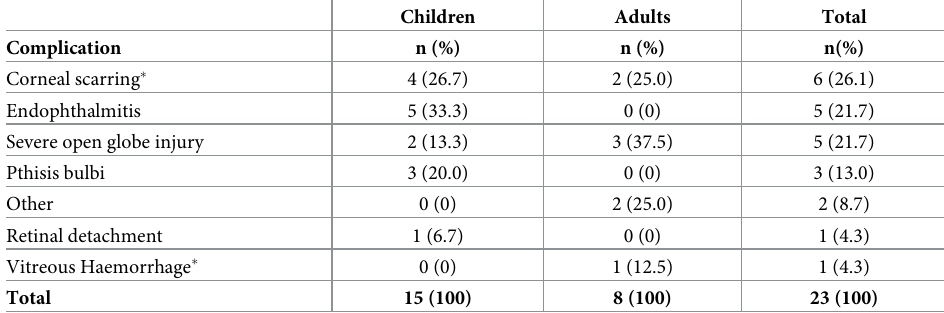
Table 5. Complications of ocular trauma resulting in monocular blindness at eight weeks.